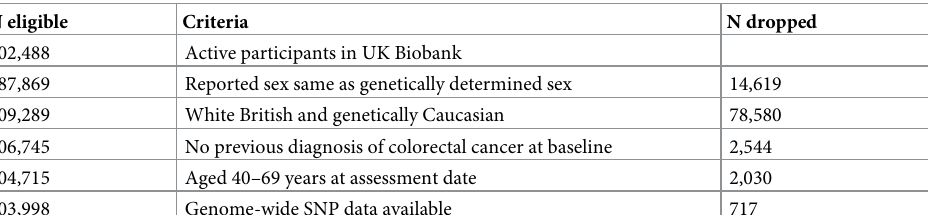
Table 1. Eligibility